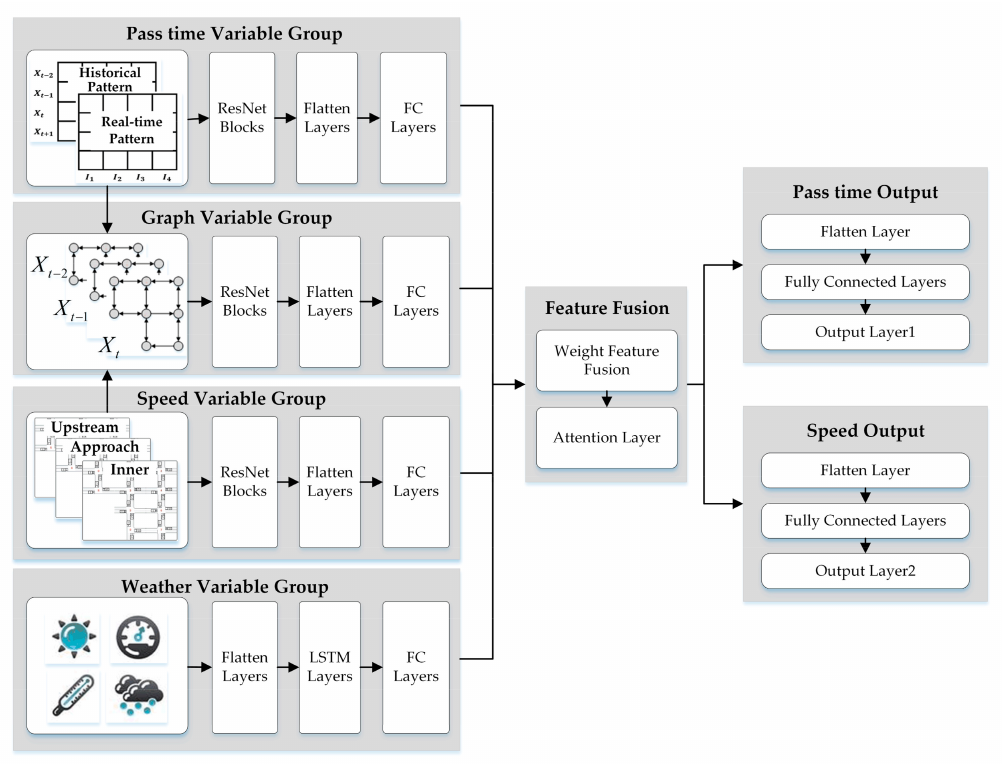
Figure 8. Multi-task fusion deep learning model framework.